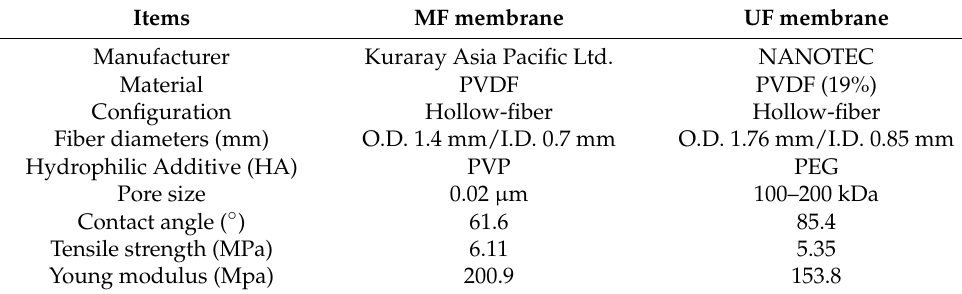
Table A1. Measured properties of the MF and UF membranes.